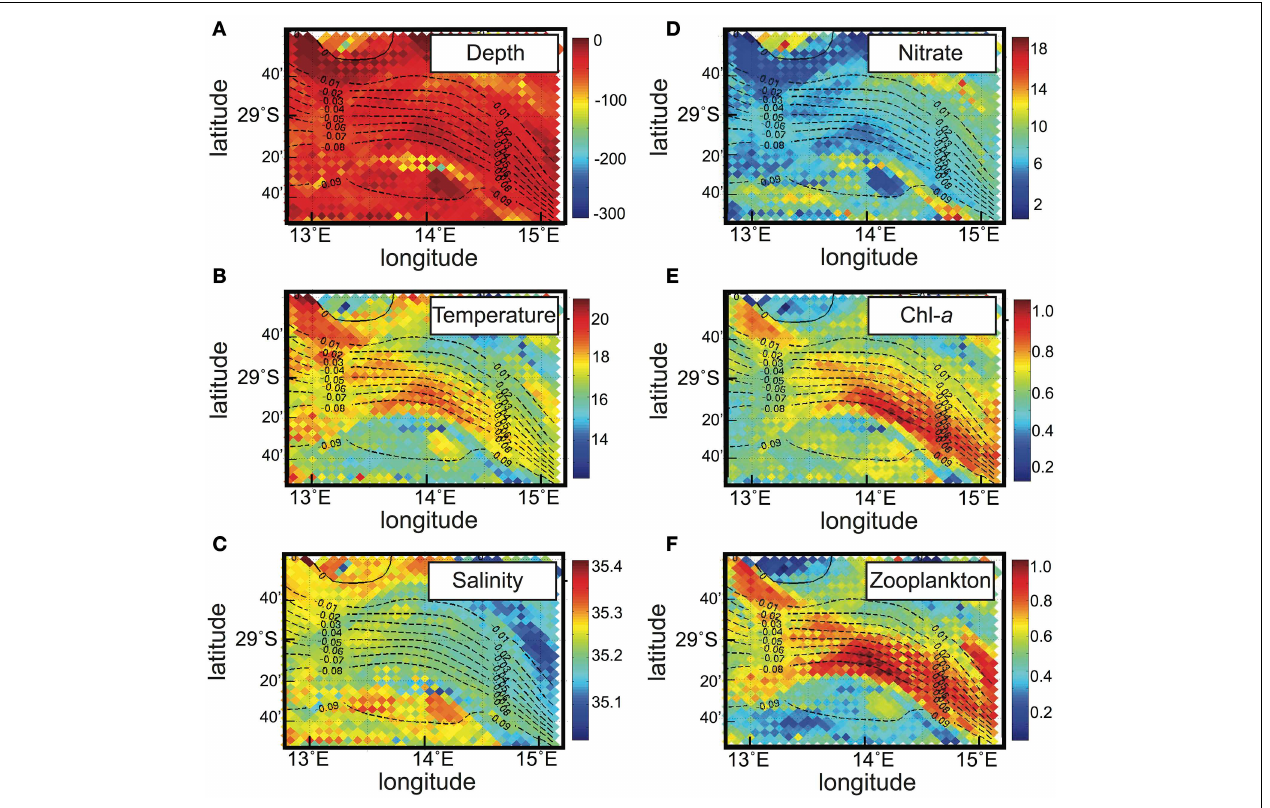
FIGURE 3 | Results from a quantitative experiment in the Benguela Current upwelling system (Figure 2A). Vertical averages of (A) depth (m), (B) temperature ( ◦ C), (C) salinity, (D) nitrate concentration (mmolN m − 3 ), (E) chlorophyll-a concentration (mg Chl-a m − 3 ) and (F) zooplankton